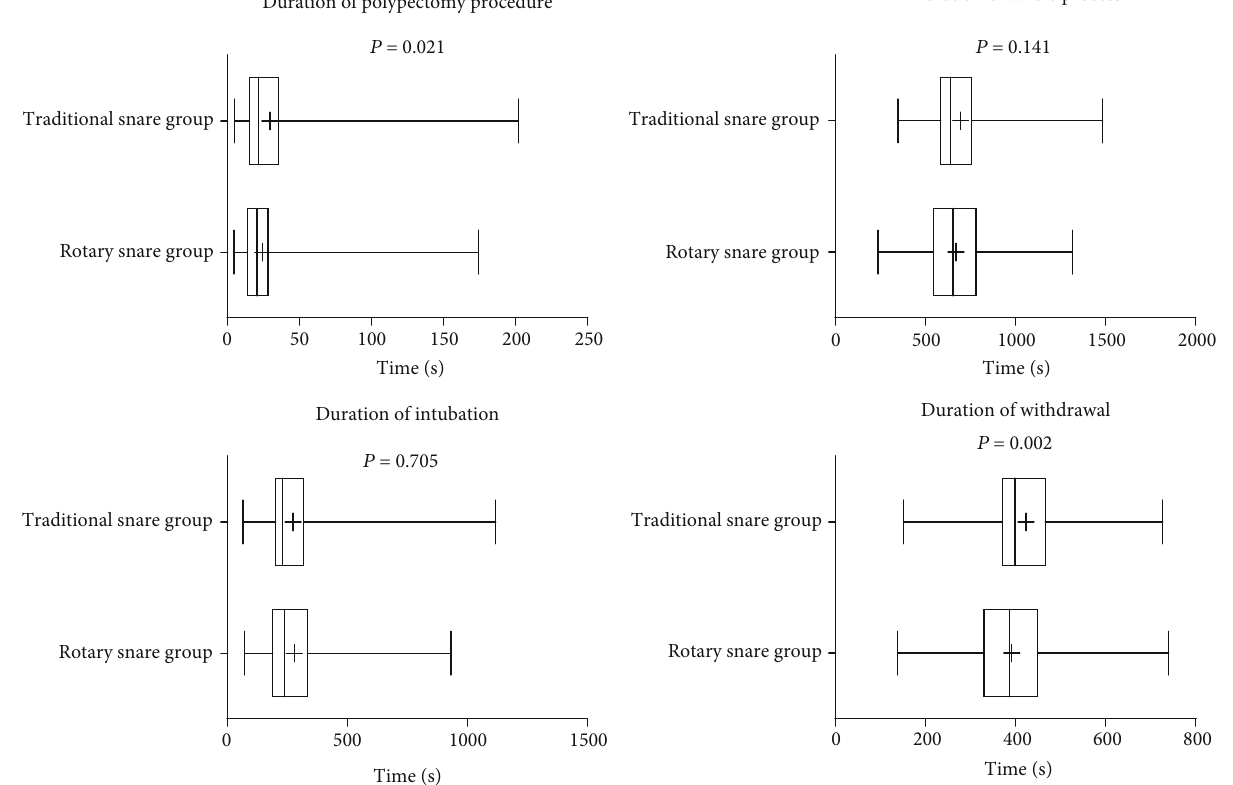
Figure 2: Comparison of each procedure time between the traditional snare group and rotary snare